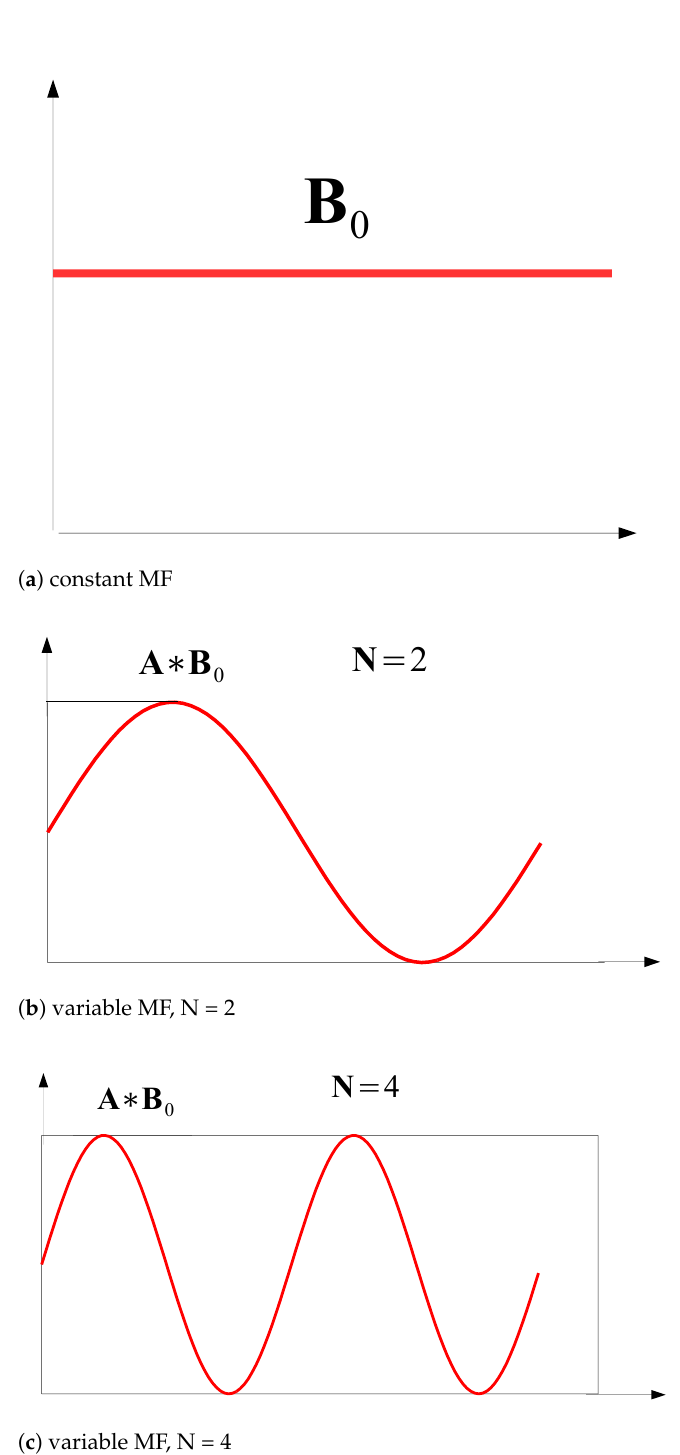
Figure 2. Configurations for constant MF ( a ) and variable MF ( b , c